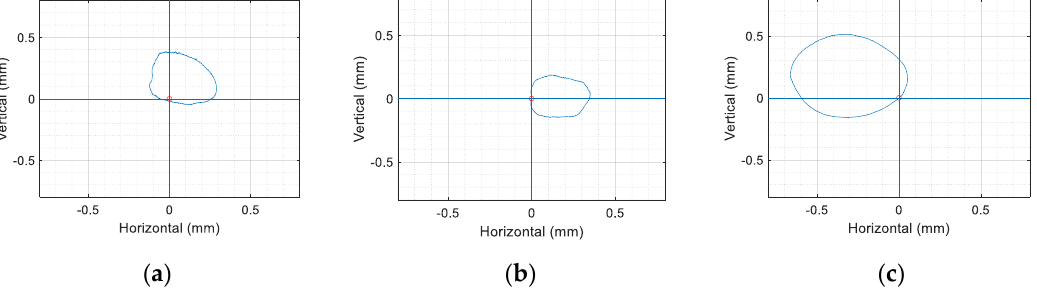
Figure 16. The comparison of the movement characters of the rotating coil at 60 RPM: ( a ) shaft orbit at DE side; ( b ) shaft orbit at center; ( c ) shaft orbit at NDE side.